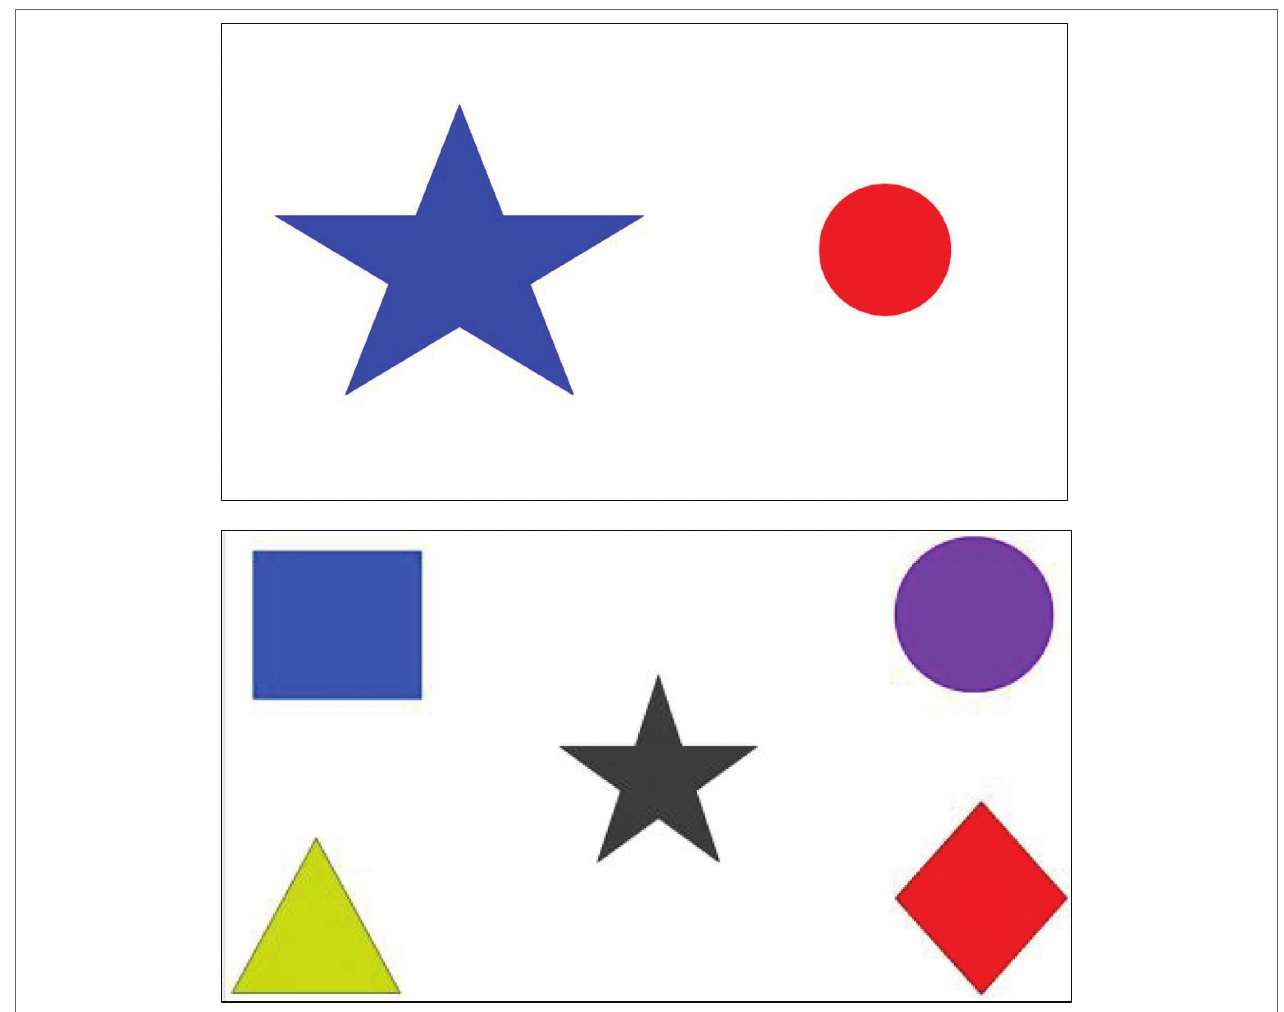
FIGURE 1 | Images shown to children (top: under 7 years; bottom: 7 years and